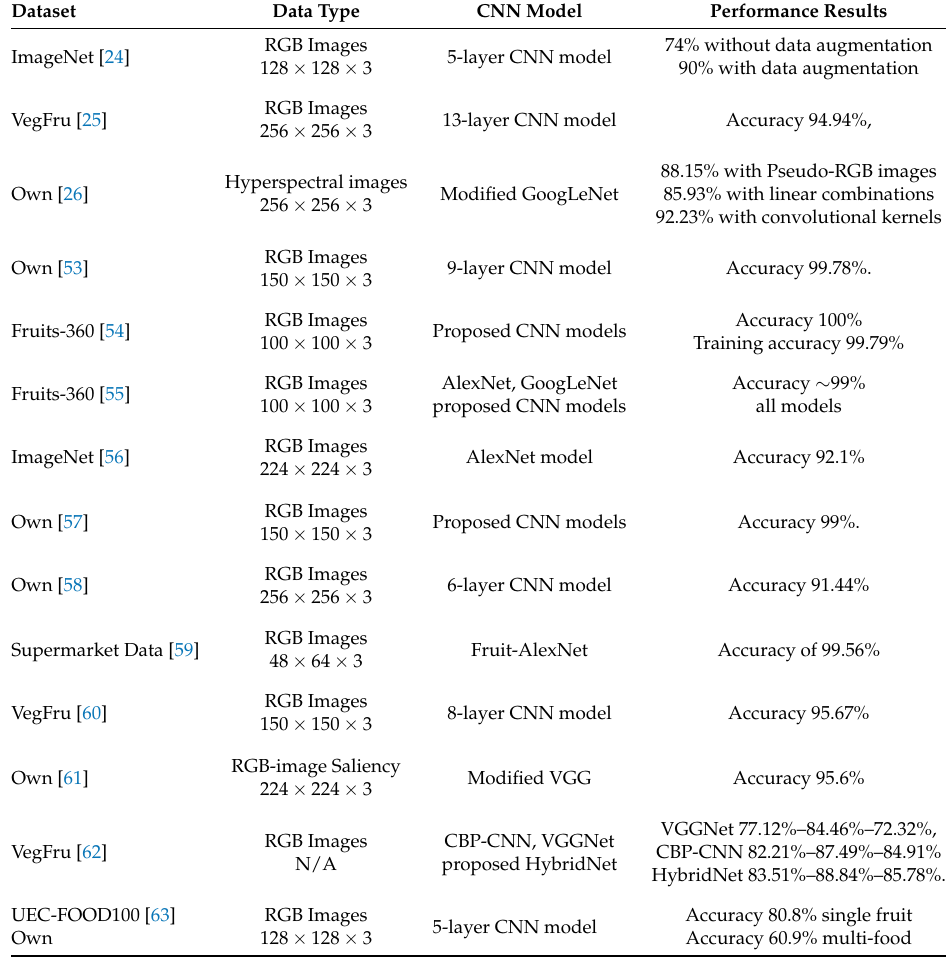
Table 1. Summary of state-of-the-art CNN-based approaches applied for fruit classification tasks.